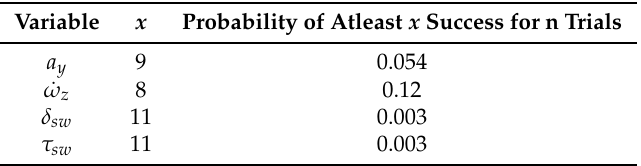
Table 1. Cumulative Binomial distribution of random success of all